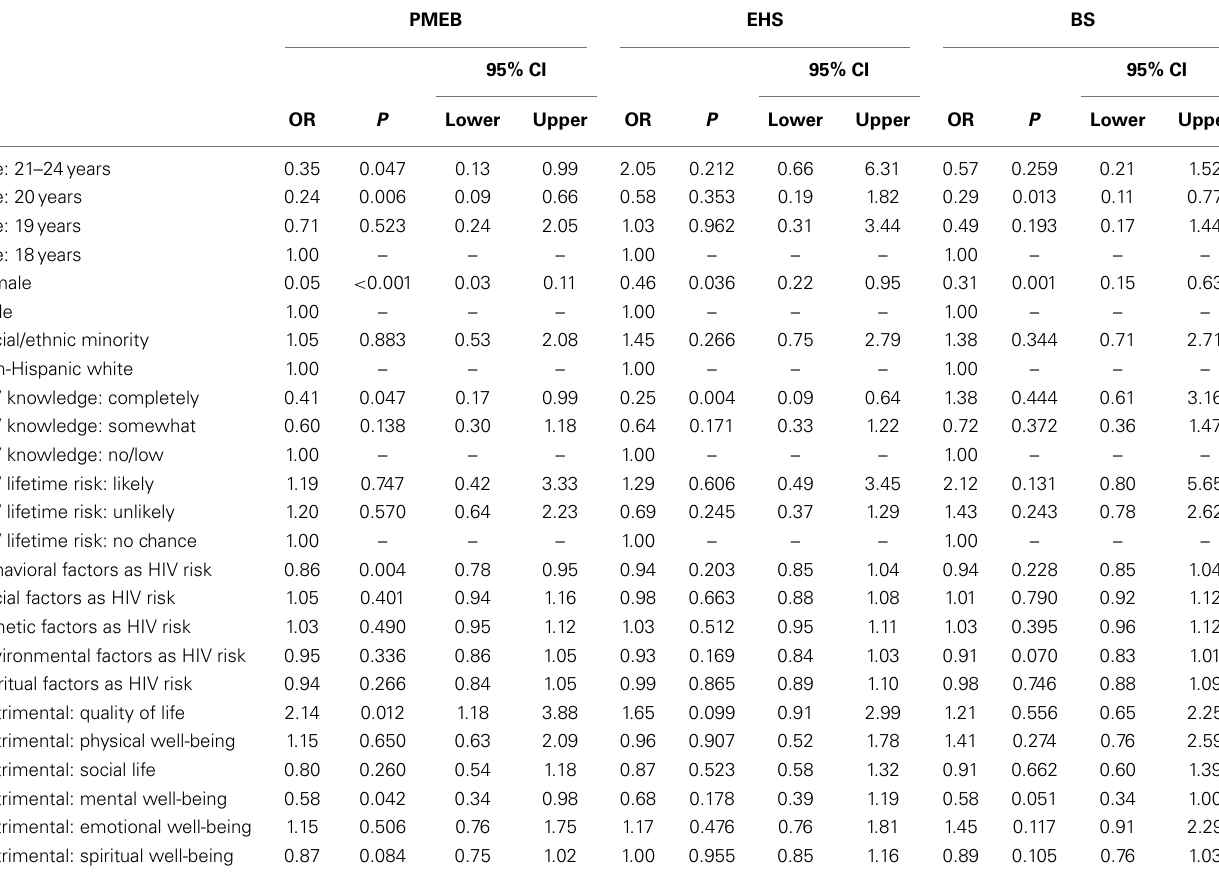
Table 5 | Factors associated with secondary academic major groups